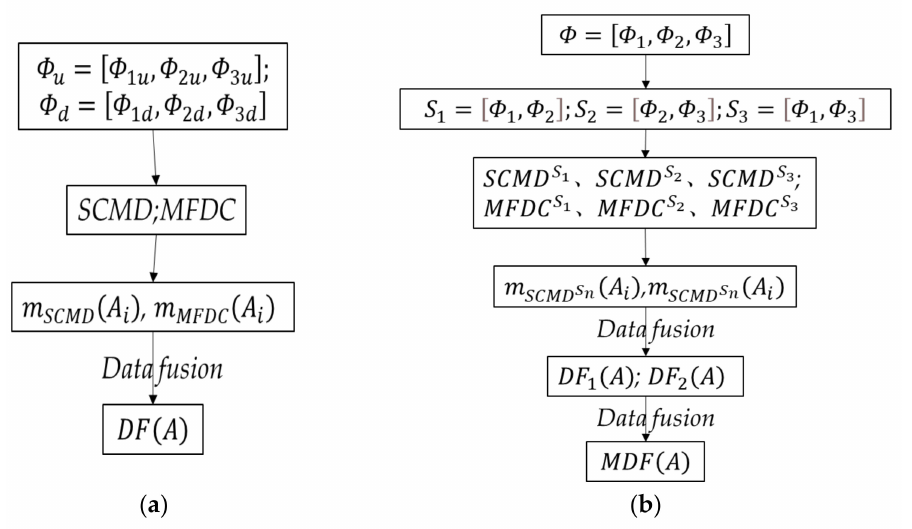
Figure 2. The damage identification method based on multi-index data fusion. ( a ) one-stage fusion; ( b ) two-stage